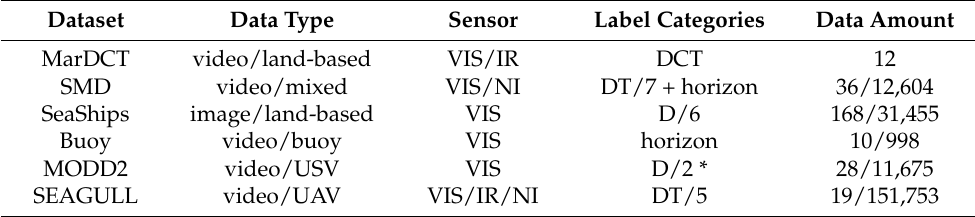
Table 2. Public datasets for ship object